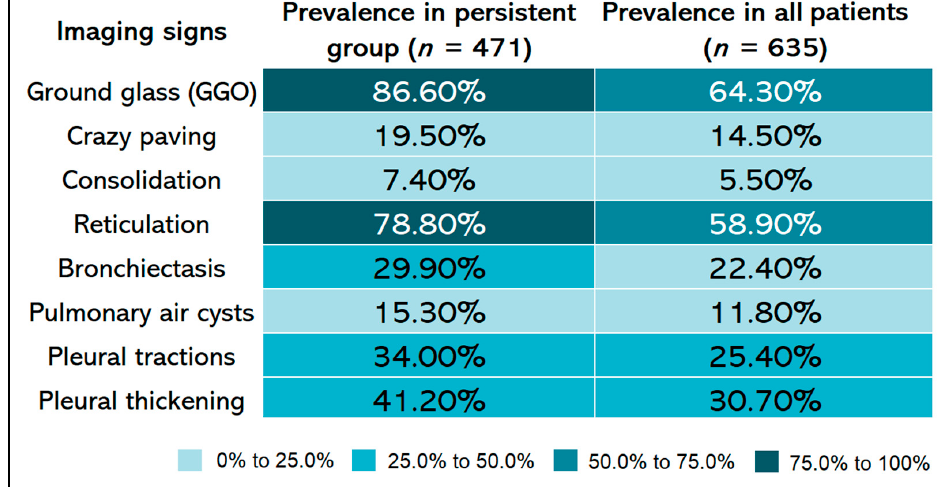
Figure 1. The prevalence of persistent post-COVID imaging signs using HRCT at 90 days follow-up.